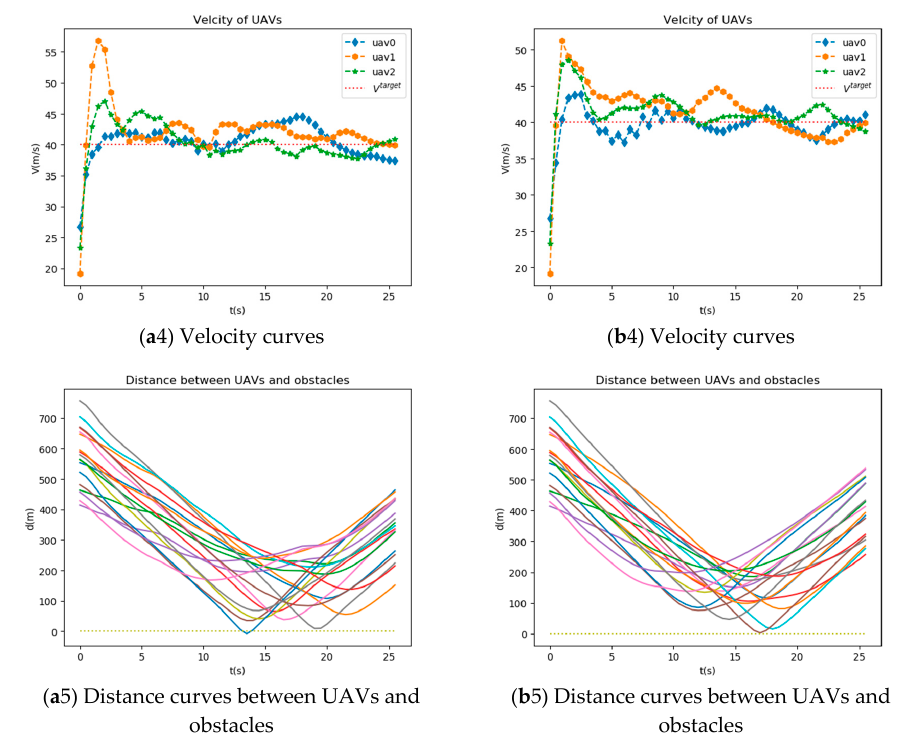
Figure 5. The trajectory curves, distance curves, altitude curves, velocity curves, and distance curves between UAVs and obstacles of UAVs after training using MAIPPO algorithm and MAJPPO algorithm. ( a 1– a 5) is the result of the MAIPPO algorithm formation obstacle avoidance test, and ( b 1– b 5) is the result of the MAJPPO algorithm formation obstacle avoidance test.